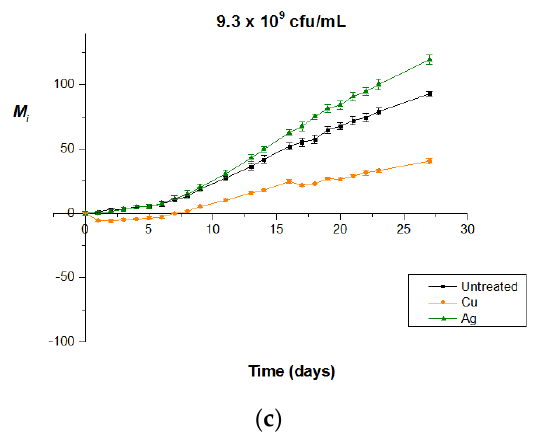
Figure 4. Bactericidal activity of copper and silver enriched untreated PMMA surfaces (i.e., without plasma micro-nanotexturing) for various Synechococcus sp. PCC 7942 concentrations of ( a ) 2.3 × 10 9 cfu/mL, ( b ) 4.6 × 10 9 cfu/mL, and ( c ) 9.3 × 10 9 cfu/mL. In all concentrations, copper outperforms silver, all the while enabling long-term maintenance of bacteria-killing properties.